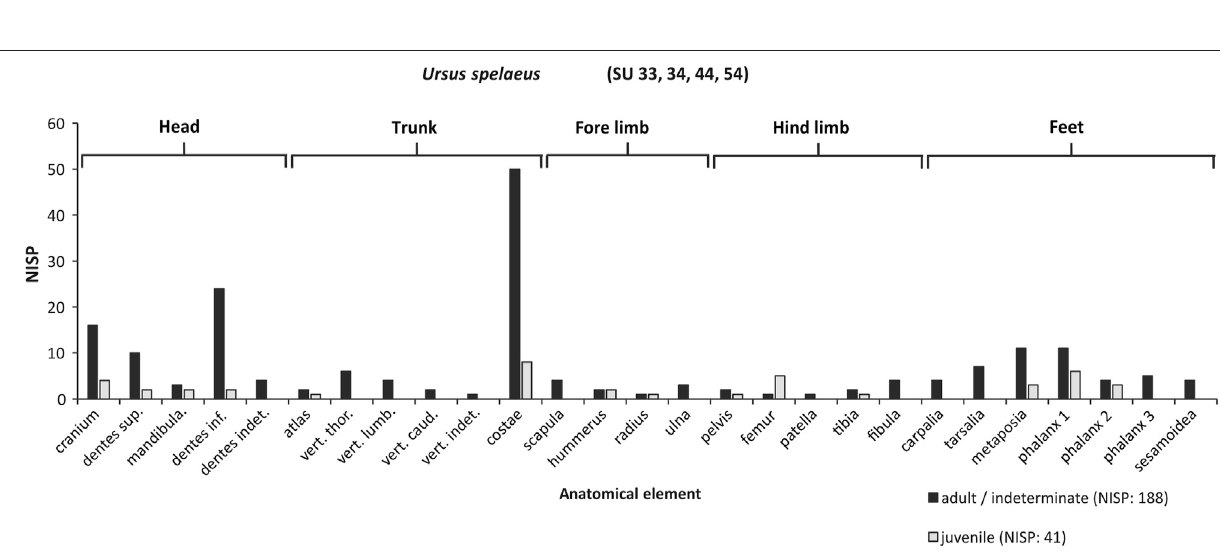
Frontiers in Earth Science |